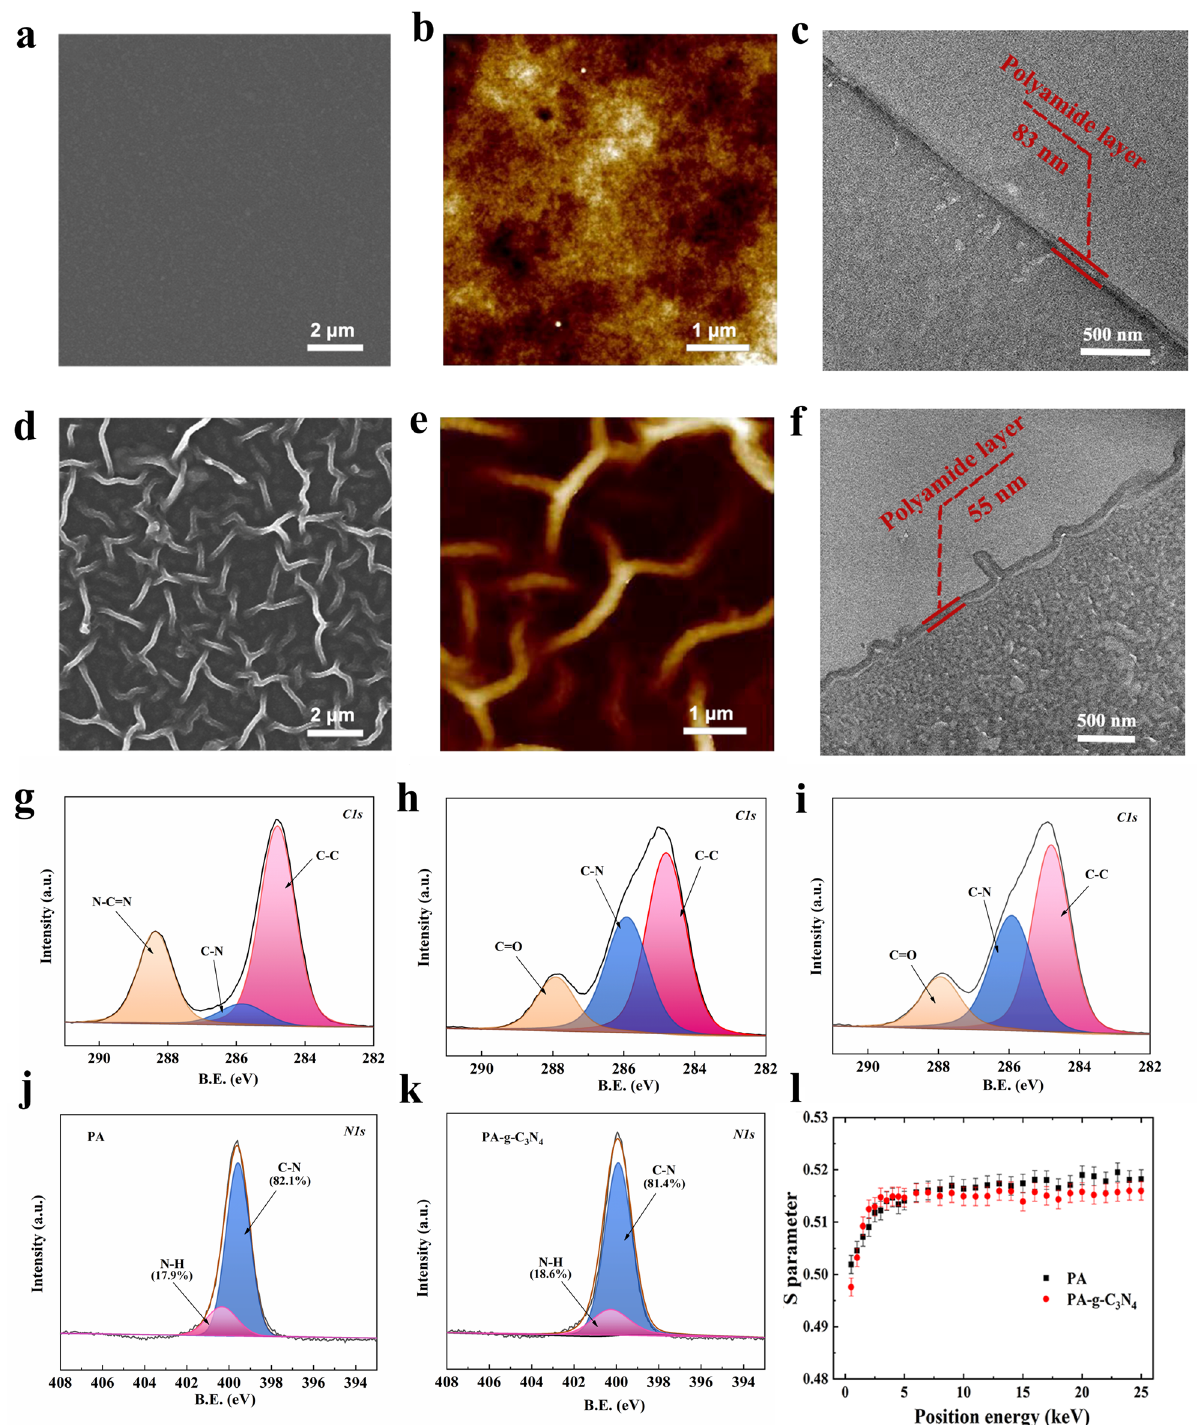
Fig. 3 | Characterizations of NF membranes. a The SEM surface morphology of the PA membrane. b The AFM image of thePAmembrane. c The TEM morphology of PA membrane. d The SEM surface morphology of the PA-g-C 3 N 4 membrane. e TheAFM image of the PA-g-C 3 N 4 membrane; f The TEM morphology of the PA-g- C 3 N 4 membrane. g – i C1s XPS spectra for g-C 3 N 4 , PA, and PA-g-C 3 N 4 membrane